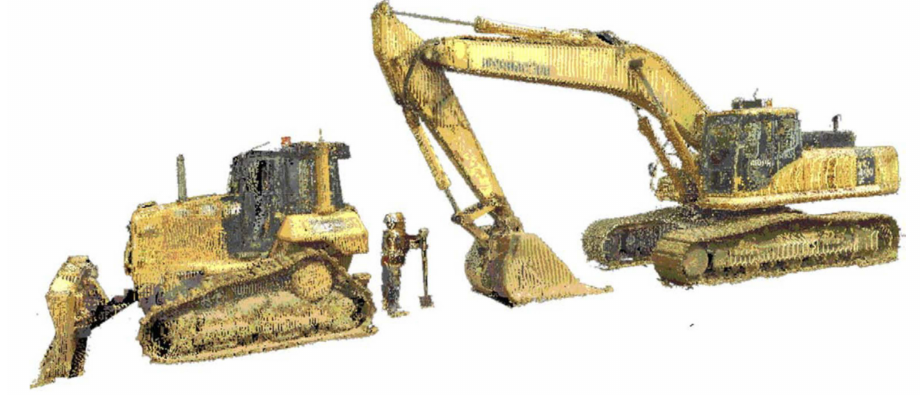
Figure 7. Hazardous situation of worker and equipment measured by a 3D laser scanner